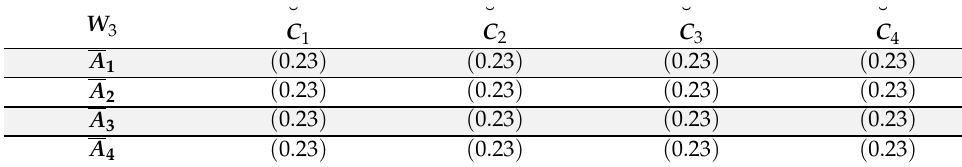
Table 12. Decision matrix in which find the value of W 3